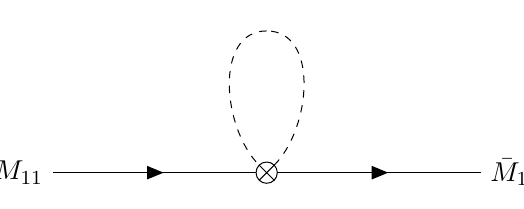
Figure 4. The crossed dot indicates the vertices essentially originates from the contraction of V super(cid:12)eld (see below for detailed explanation) and the explicit expression can be read o(cid:11) from (7.7). The dashed line denote both moduli, Z j and M 1 a proparating in the 1